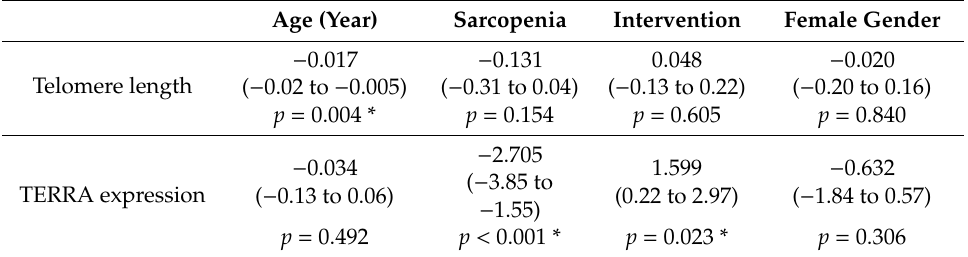
* indicates p < 0.05. TERRA: telomeric repeat-containing